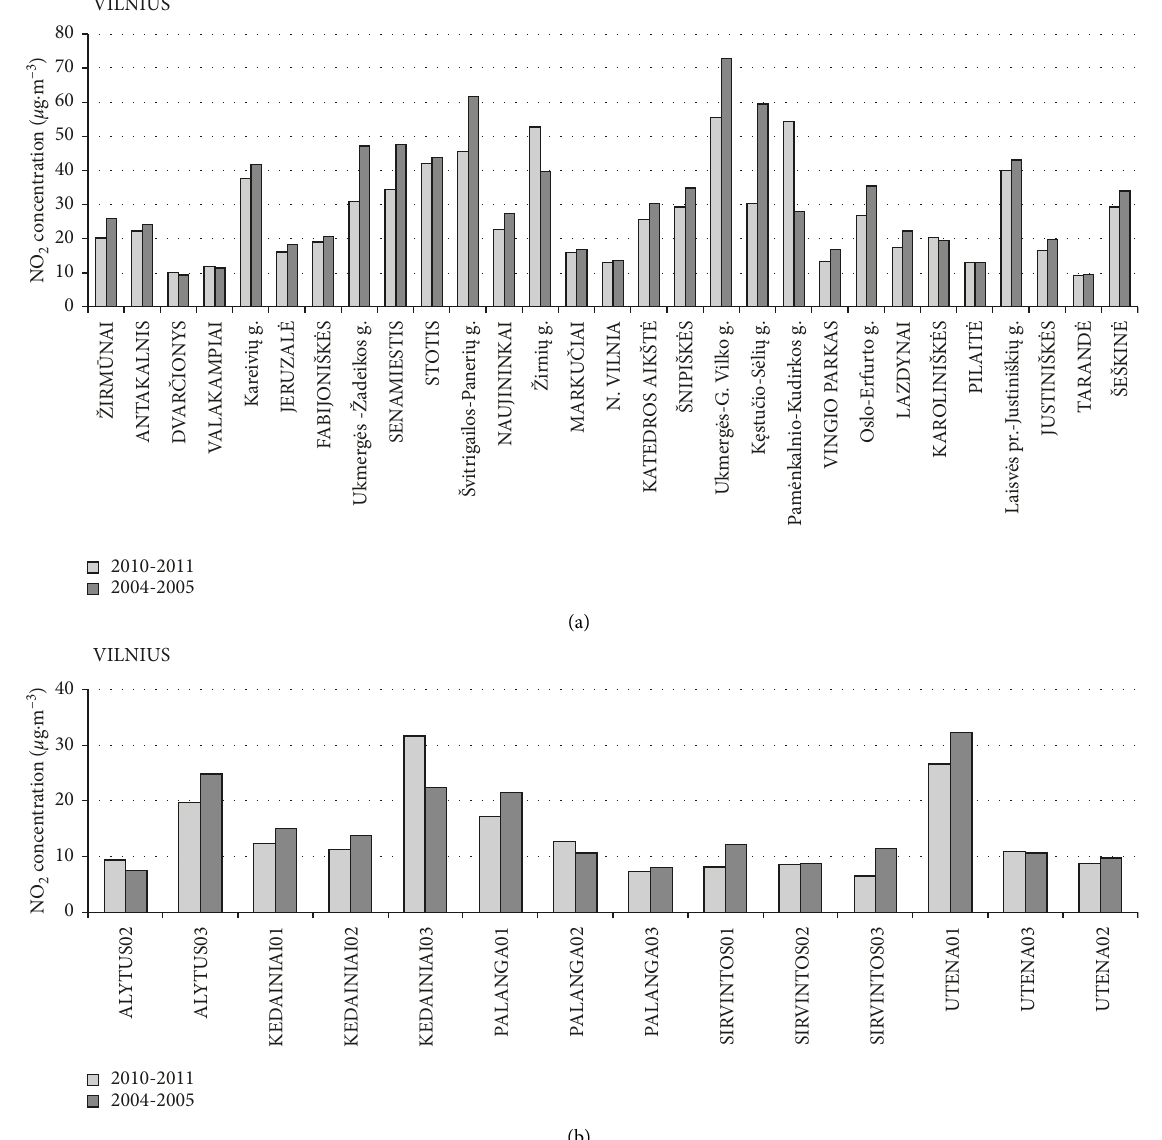
Figure 10: Time series of mean NO